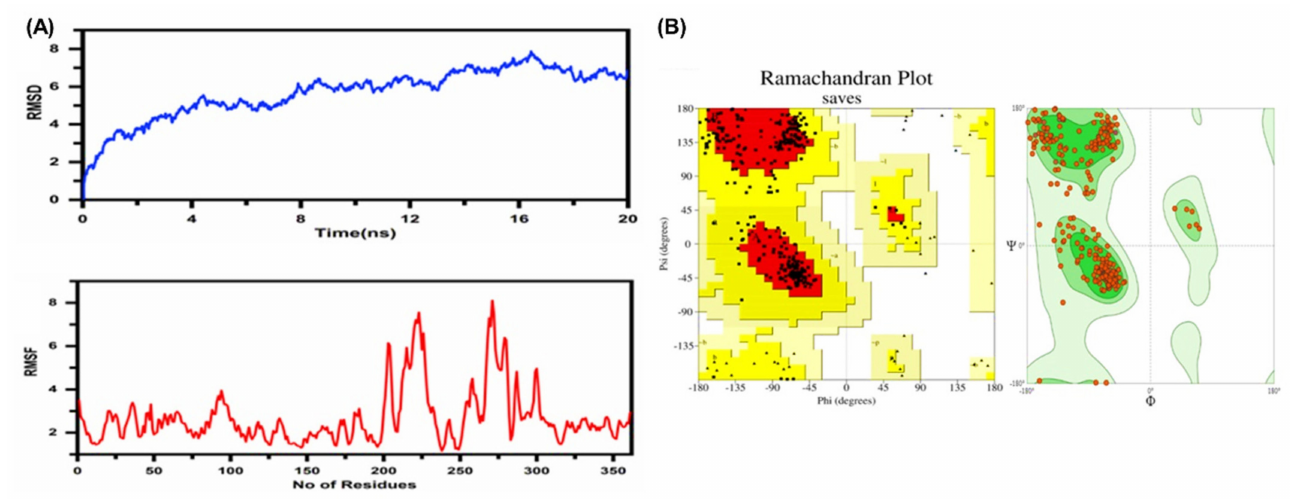
Figure 6. ( A ) The RMSD and RMSF graphs obtained during the molecular dynamics simulation (MD) analysis of the immunogen design. The plots maintained an average flexibility of 2.5 Å with a maximum of 7.0 Å in the highly flexible section. ( B ) Post-simulation Ramachandran